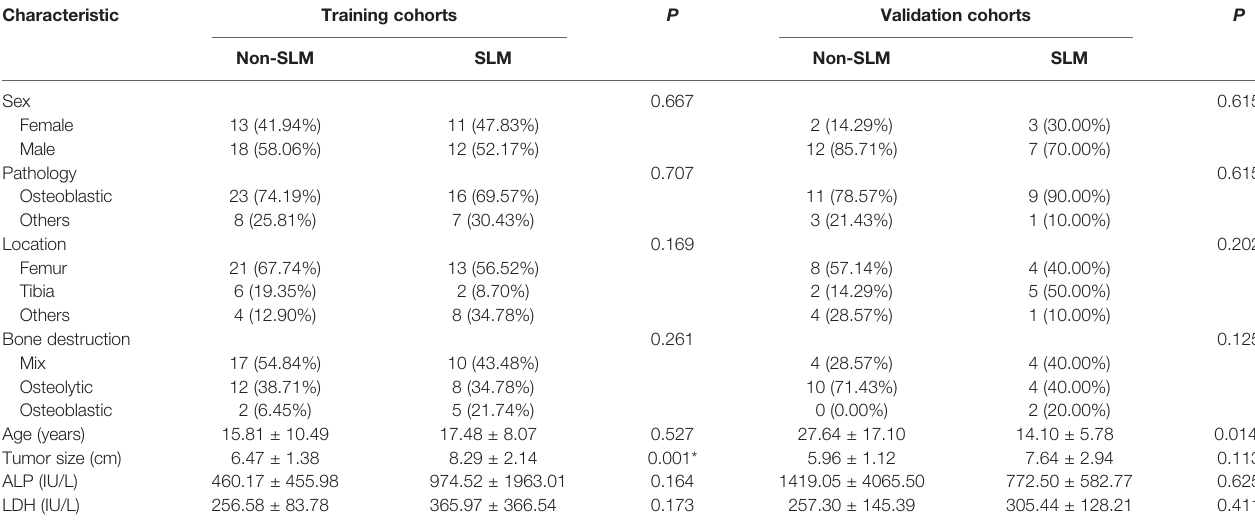
TABLE 3 | The clinical characteristics of these cohorts in terms of SLM and non-SLM of osteosarcoma.